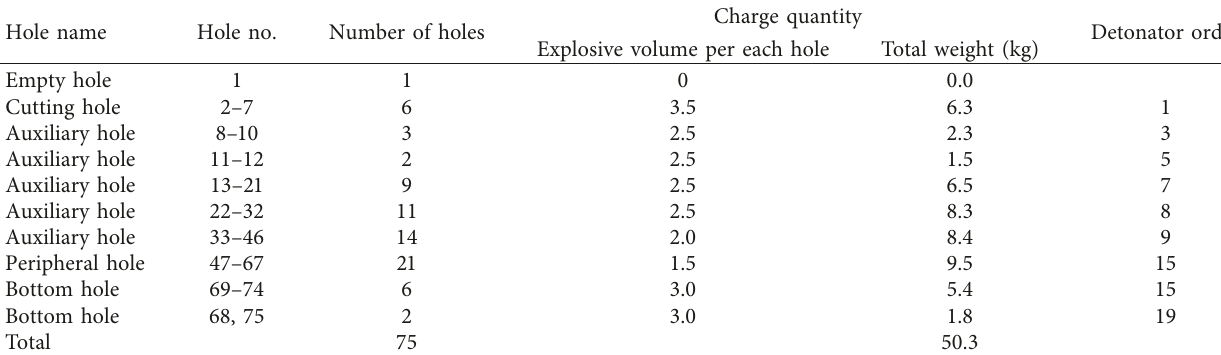
Figure 5: Blasting scheme of duplex wedge hole cutting (unit: mm). Table 1: Blasting parameters table for the